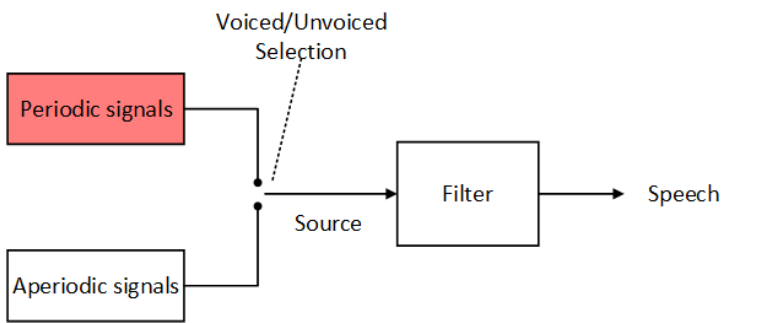
Figure 1. The procedure of generating speech based on the source-filter model. The red part indicates what EGG signals